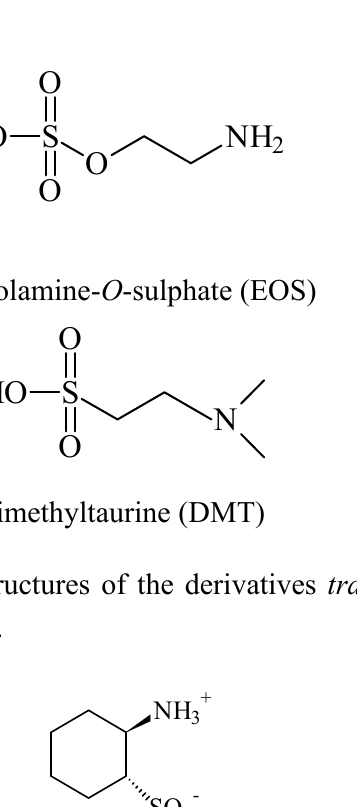
Figure 4. Structures of ethanolamine- O -sulphate (EOS), 2-aminoethylphosphonic acid (AEP), dimethyltaurine (DMT) and trimethyltaurine (TMT) with GABA antagonism.